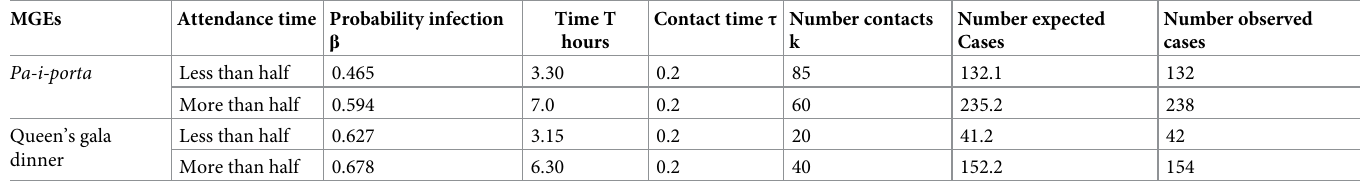
Table 10. Attendance at pa-i-porta and Queen’s gala dinner MGEs and number of contacts (k) to obtain expected cases of COVID-19 compared with observed cases from the formula of Tupper and co-authors [63].